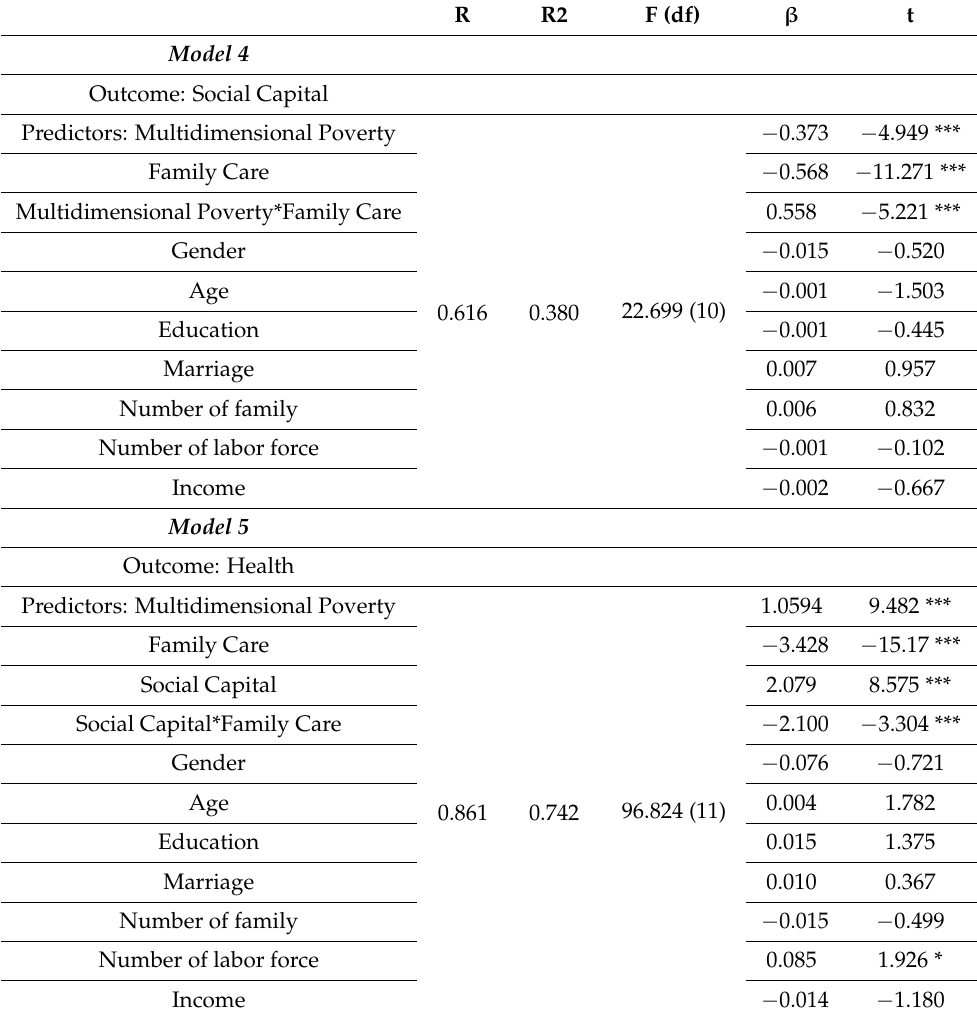
Table 6. Mediating effects test with